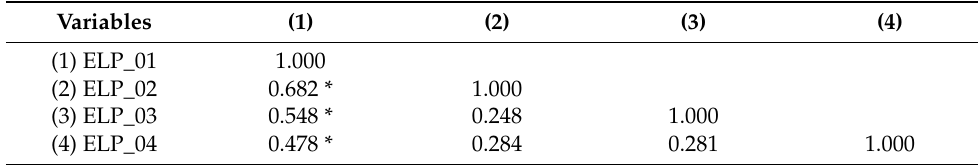
Table 14. Pearson correlations by e-learning process